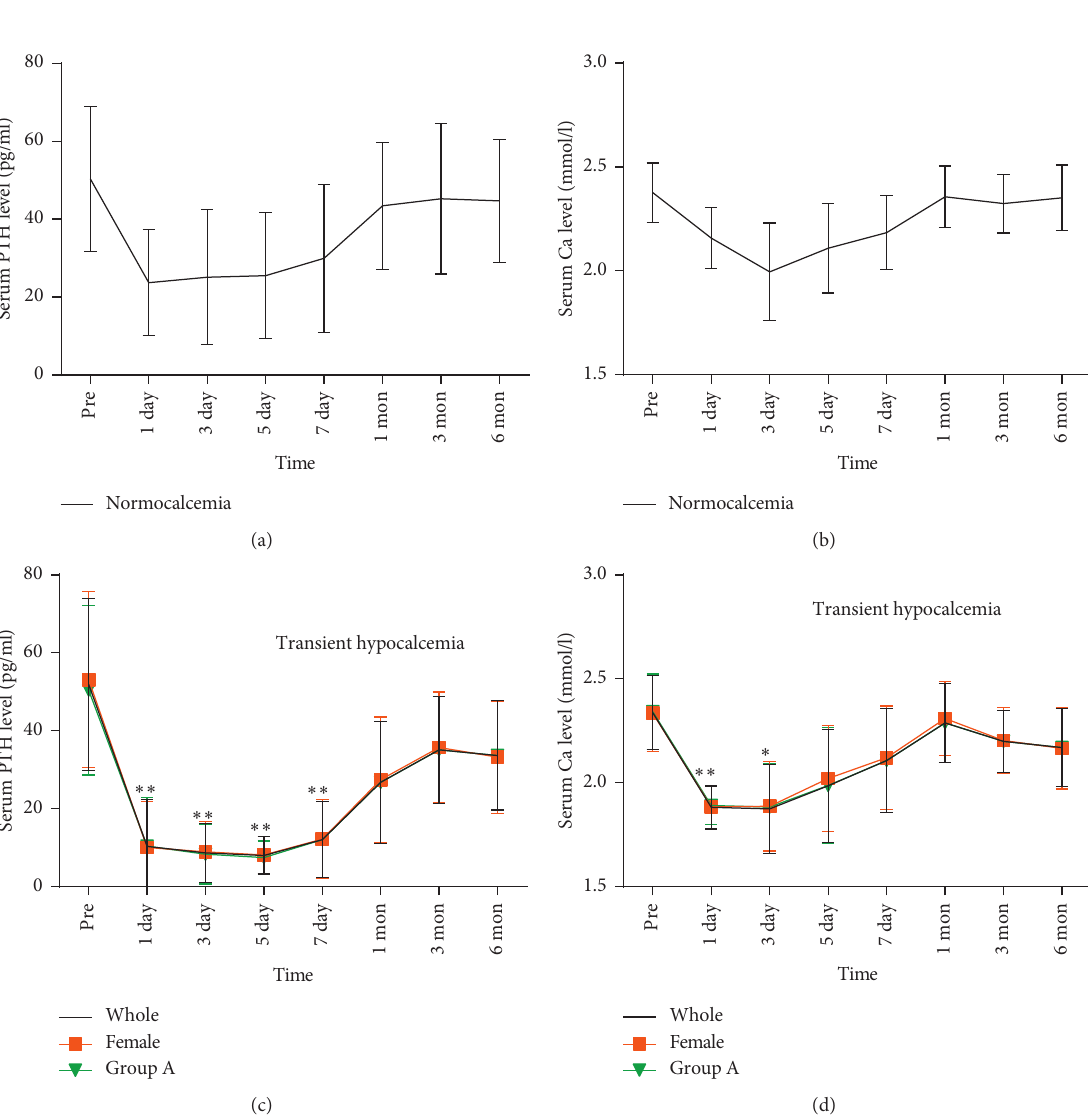
Figure 1: Changes in serum PTH and Ca before and after total thyroidectomy: (a) PTH and (b) Ca levels in patients who developed normocalcemia; (c) PTH and (d) Ca levels in patients who developed transient hypocalcemia. ∗ p < 0.05 vs. preoperative; ∗∗ p < 0.01 vs. preoperative. Pre,